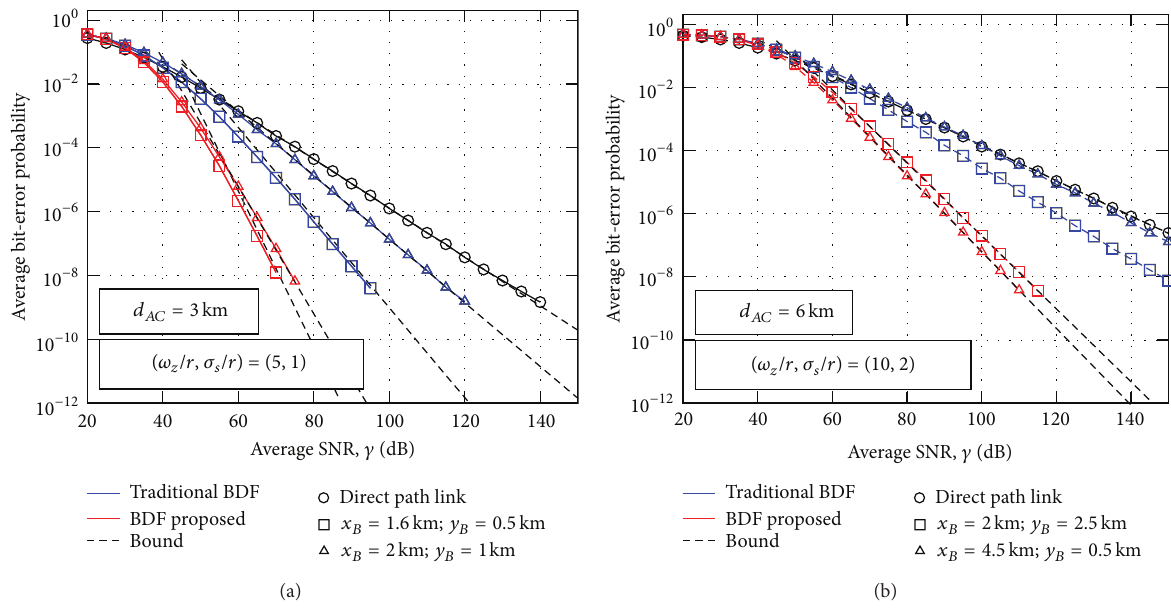
Figure 4: BER performance when different relay locations for 𝑑 𝐴𝐶 = {3,6} km are assumed together with values of normalized beamwidth and normalized jitter of (𝜔 𝑧 /𝑟, 𝜎 𝑠 /𝑟) = (5,1) and (𝜔 𝑧 /𝑟, 𝜎 𝑠 /𝑟) = (10, 2) ,